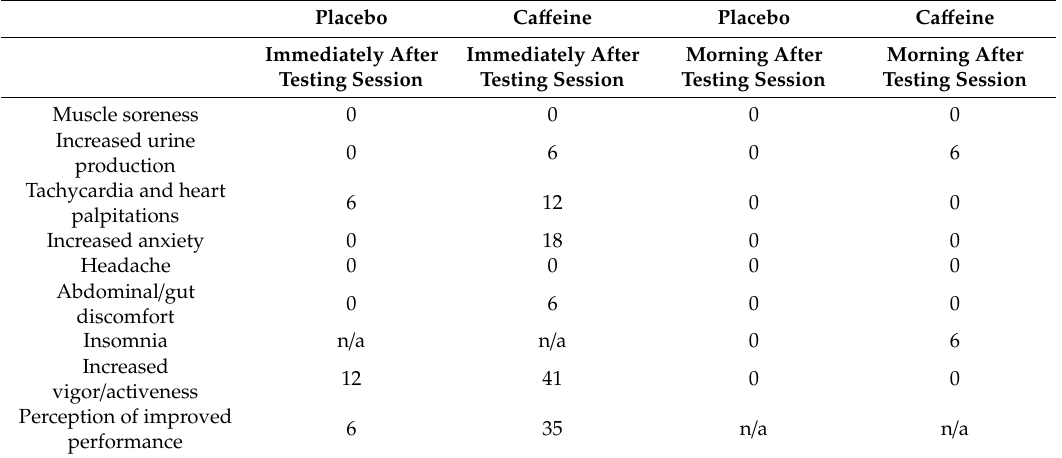
Table 3. Incidence of side e ff ects reported immediately after and the morning after ingestion of a ca ff einated gel or a